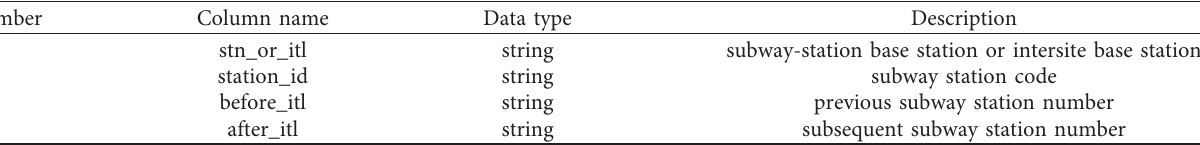
Table 2: Data tags added after